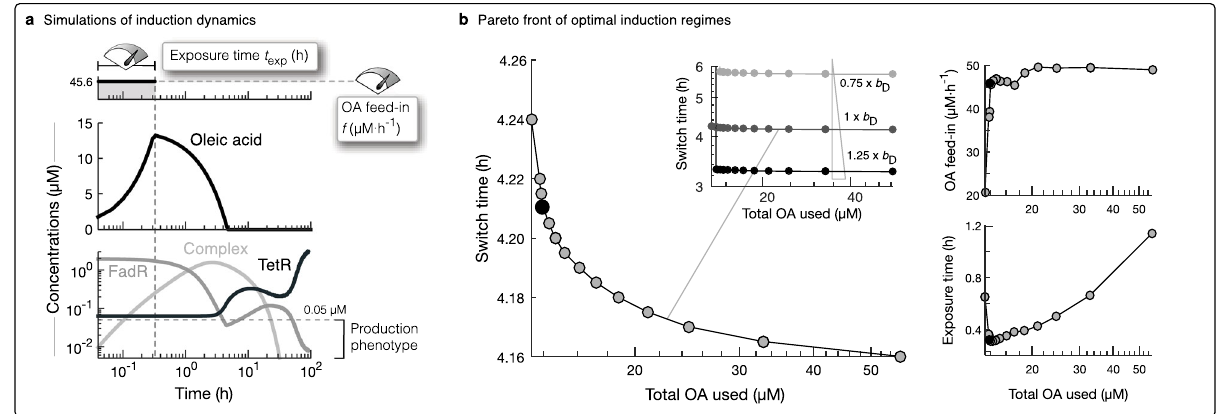
Fig. 4 Tuning induction and irreversible switch to minimise inducer use and switch time. a Simulation of induction with its two tuning dials OA feed-in fl ux ( f ) and time length of exposure ( t fi xed at f = 45.6 μ M ⋅ h − 1 and t = 0.31 h (top plot). We plot the corresponding dynamic response of oleic acid, exp ) exp free FadR, complex and TetR, over 100 hours of the induction process, also indicating the maximum concentration of FadR of 0.05 μ M for which we de fi ne the cell to be expressing the production phenotype. b Plot of the Pareto front of the induction performances achieved (left plot) for optimal feed-in fl ux and exposure times (right plots), as found from evaluating the multi-objective optimisation problem. The inset plot shows that increasing FadD